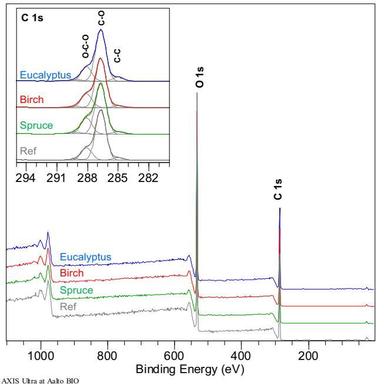
XPS survey spectra of the samples, together with a pure cellulosic reference sample (whatman filter paper). High resolution carbon C 1s region in the insert shows CeO and OeCeO components in a ratio characteristic of cellulose. Lignin would show up in the CC-component.